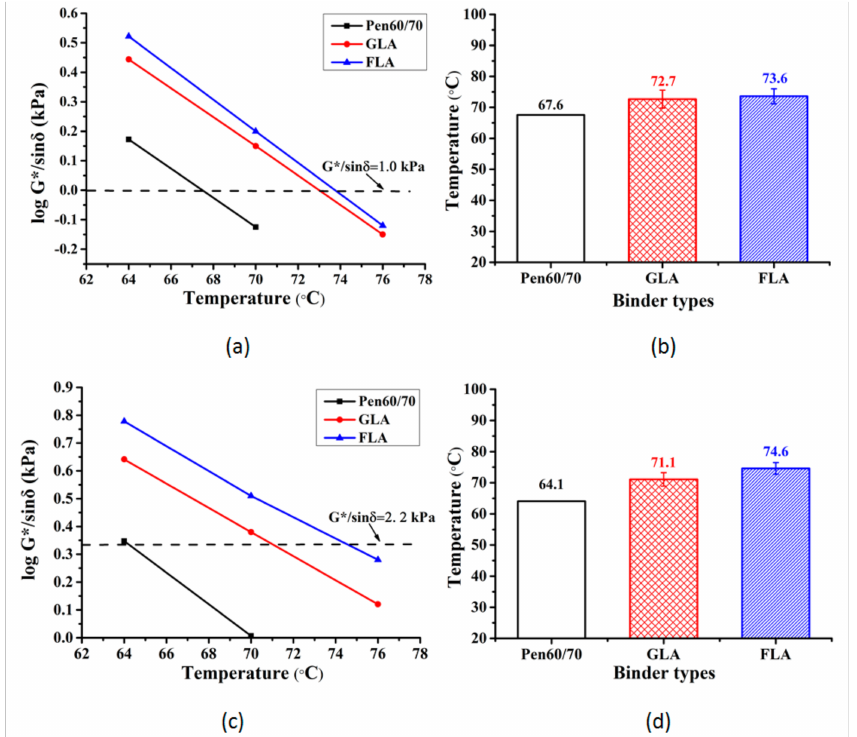
Figure 4. Superpave rutting factor test results: ( a ) rutting factor (unaged); ( b ) failure temperature (unaged); ( c ) rutting factor (short-term aged) and ( d ) failure temperature (short-term